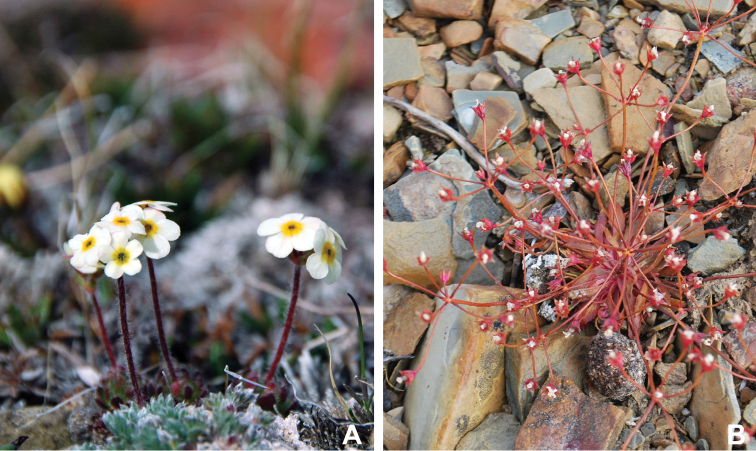
AAndrosace
chamaejasme
subsp.
andersonii habit, Gillespie et al. 7495BAndrosace
septentrionalis habit. Photo A by R.D. Bull and B by B.A. Bennett.